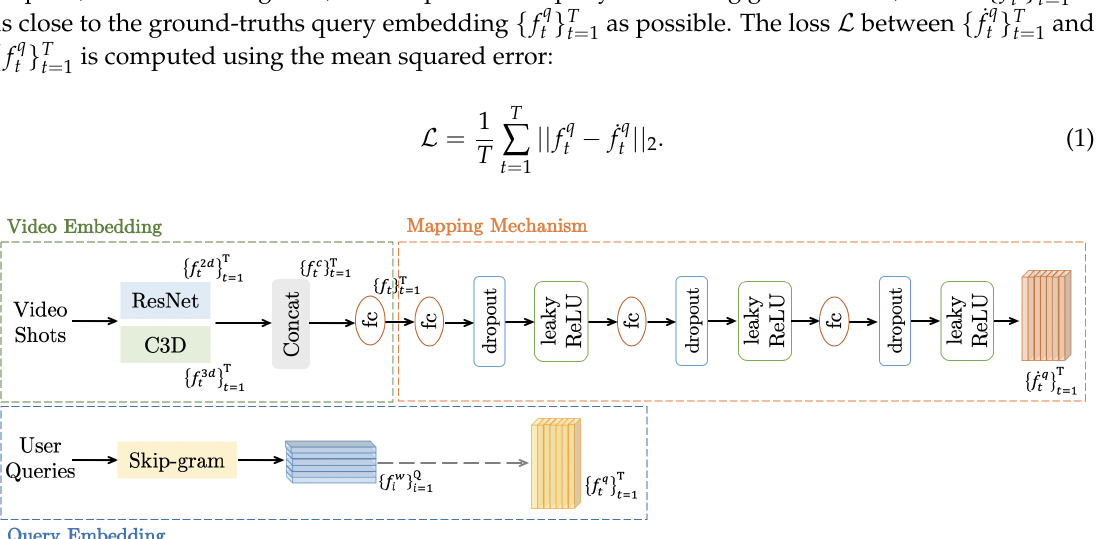
} T t t = 1 } T ) t t = 1 } T is then achieved t t = 1 } T to be close t t = 1